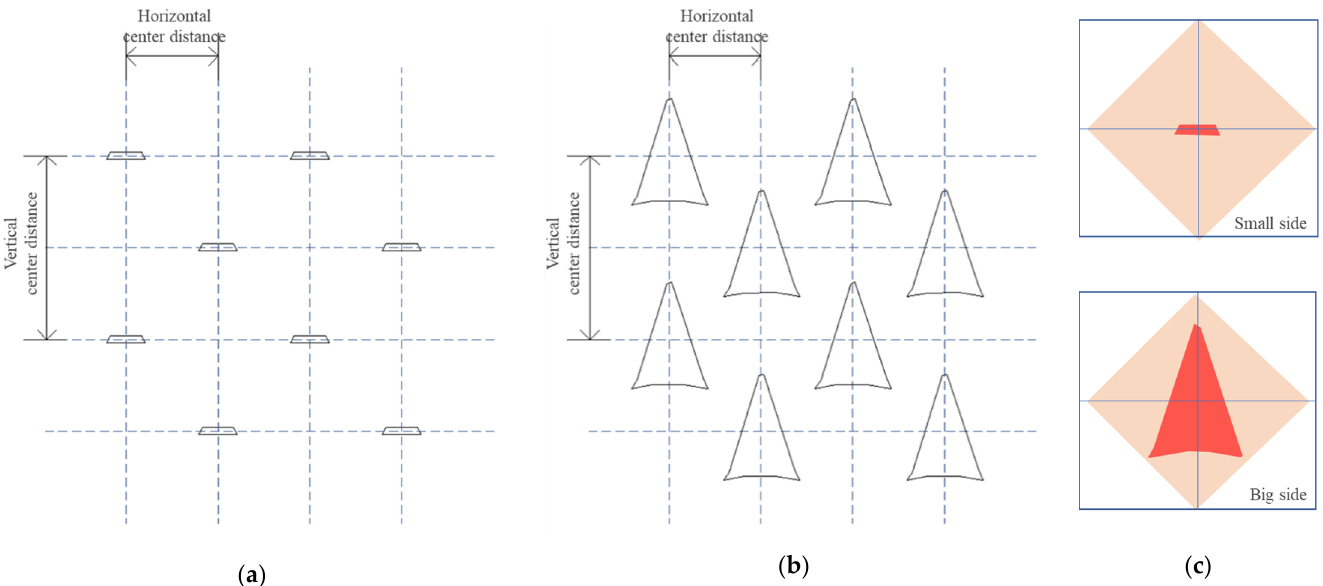
Figure 5. The perforation diagram of different sides: ( a ) Small side; ( b ) Large side; (c) Unit of each perforation.